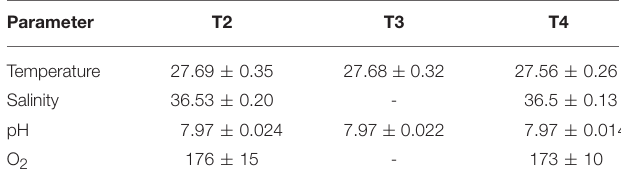
TABLE 2 | Mean ± 1 σ of temperature [Celsius], salinity, pH [total], and O 2 [ µ mol kg − 1 ] from T2, T3, and